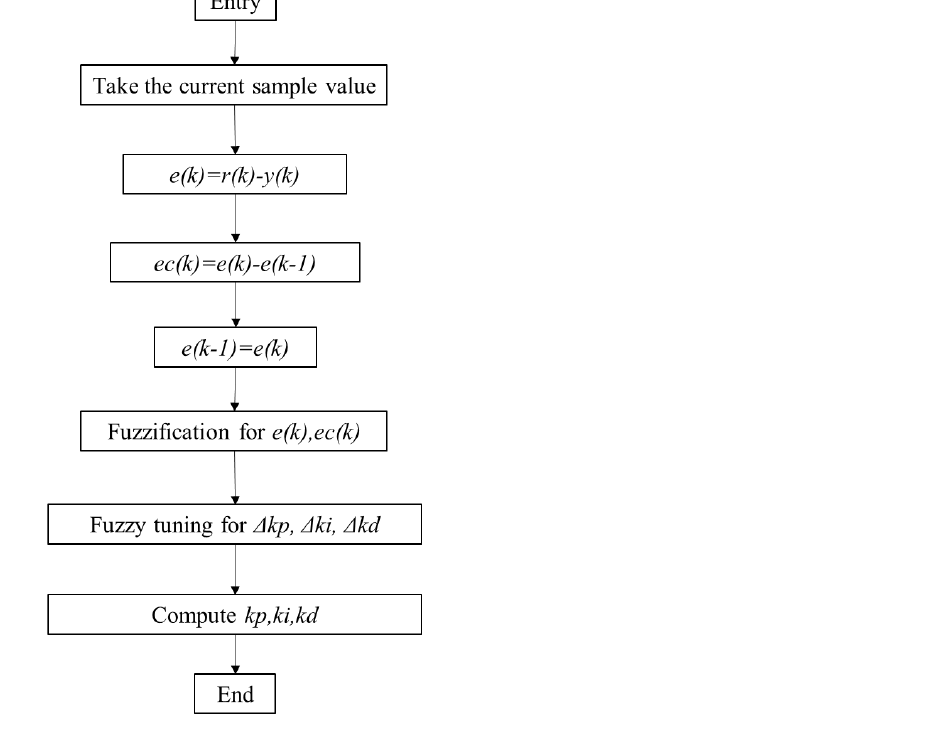
Figure 7. Workflow of the fuzzy PID controller.